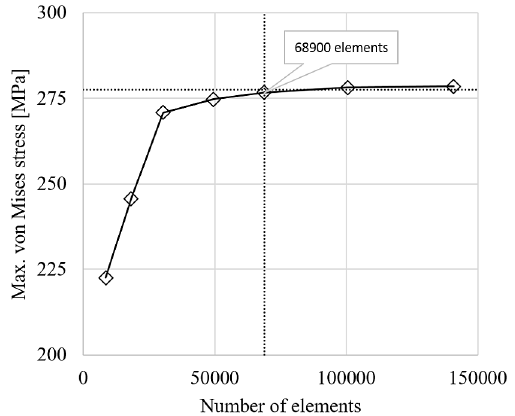
Figure 5. Maximum von Mises stress depending on the finite elements number in the influence zone.